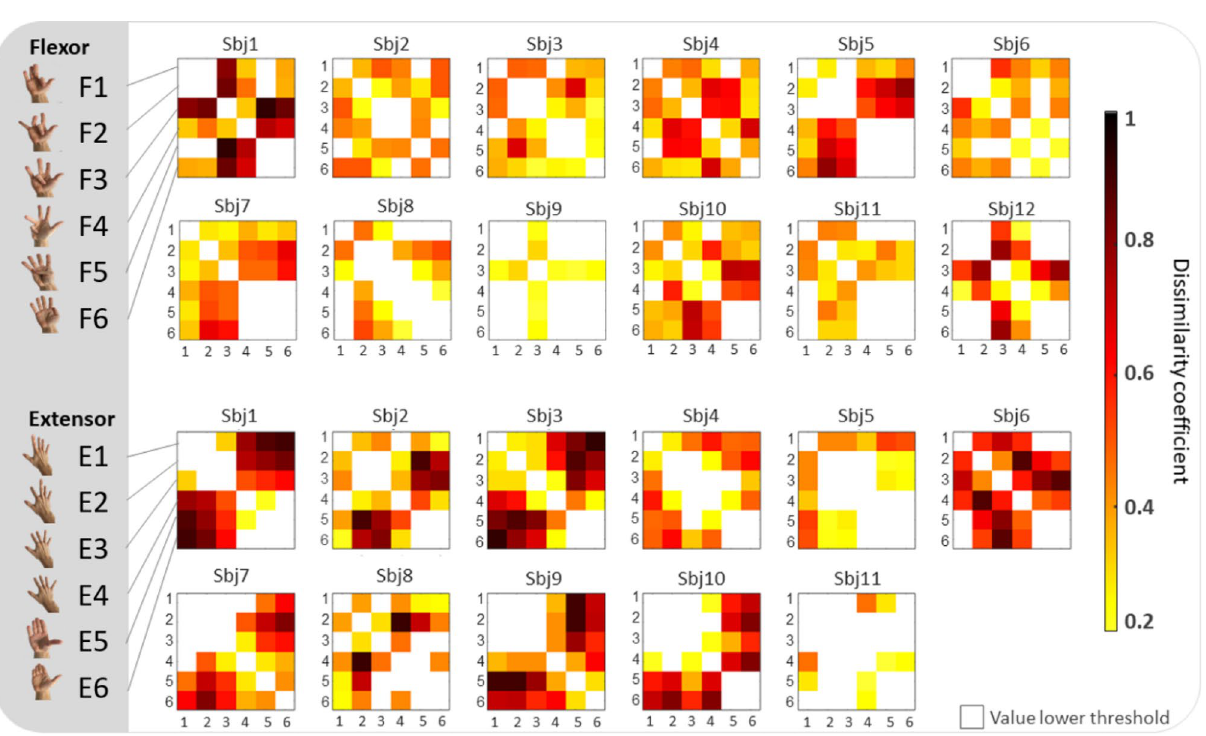
Figure 3. Intra-subject variability analysis for the flexion (F) and extension (E) tasks. The dissimilarity coefficient between pairs of gestures is shown in every subject, for the flexion (upper panel) and the extension (lower panel) sessions, separately. Values below 0.2 are not represented. Figure created with MatLab2020a and Microsoft PowerPoint